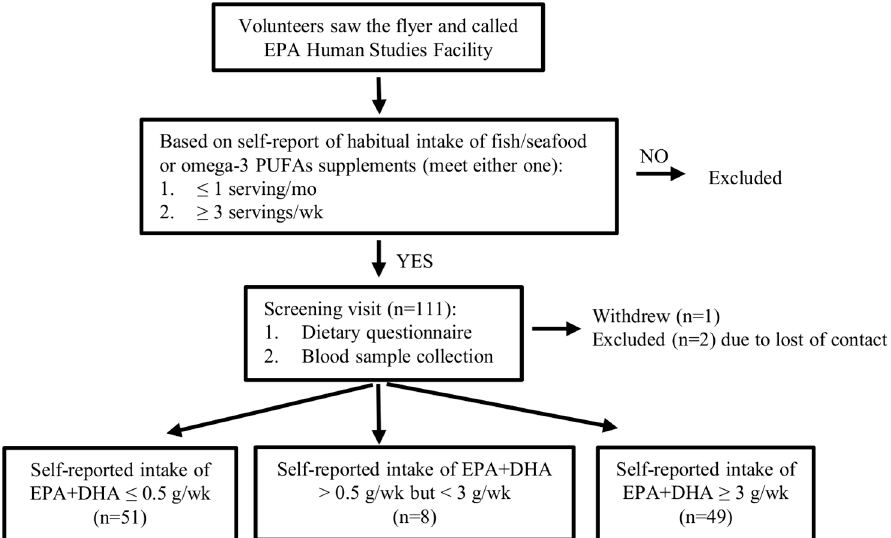
Figure 1. Study design. Based on the self-report of habitual intake of fish/seafood or omega-3 supplements, a total of 111 volunteers were invited for the screening visit where dietary questionnaire were conducted and blood samples were collected for fatty acids analysis. Nine volunteers were excluded from analysis due to the loss of contact or their dietary report did not meet the criteria. Table 1. Subject characteristics and blood levels of omega-3 fatty acids 1 .